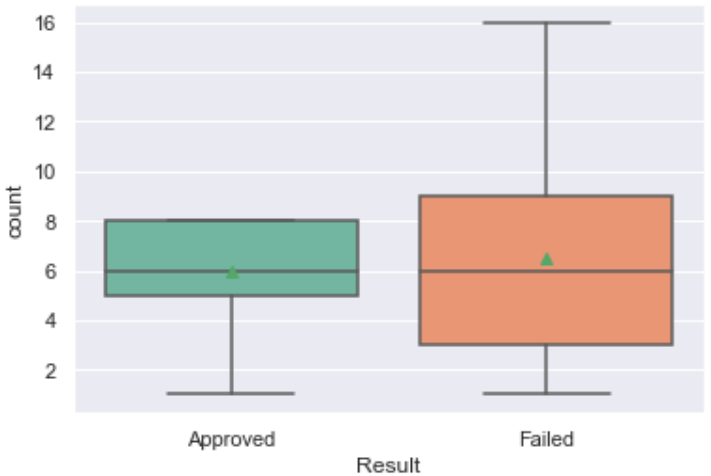
Figure 8. Number of subjects enrolled versus final status.